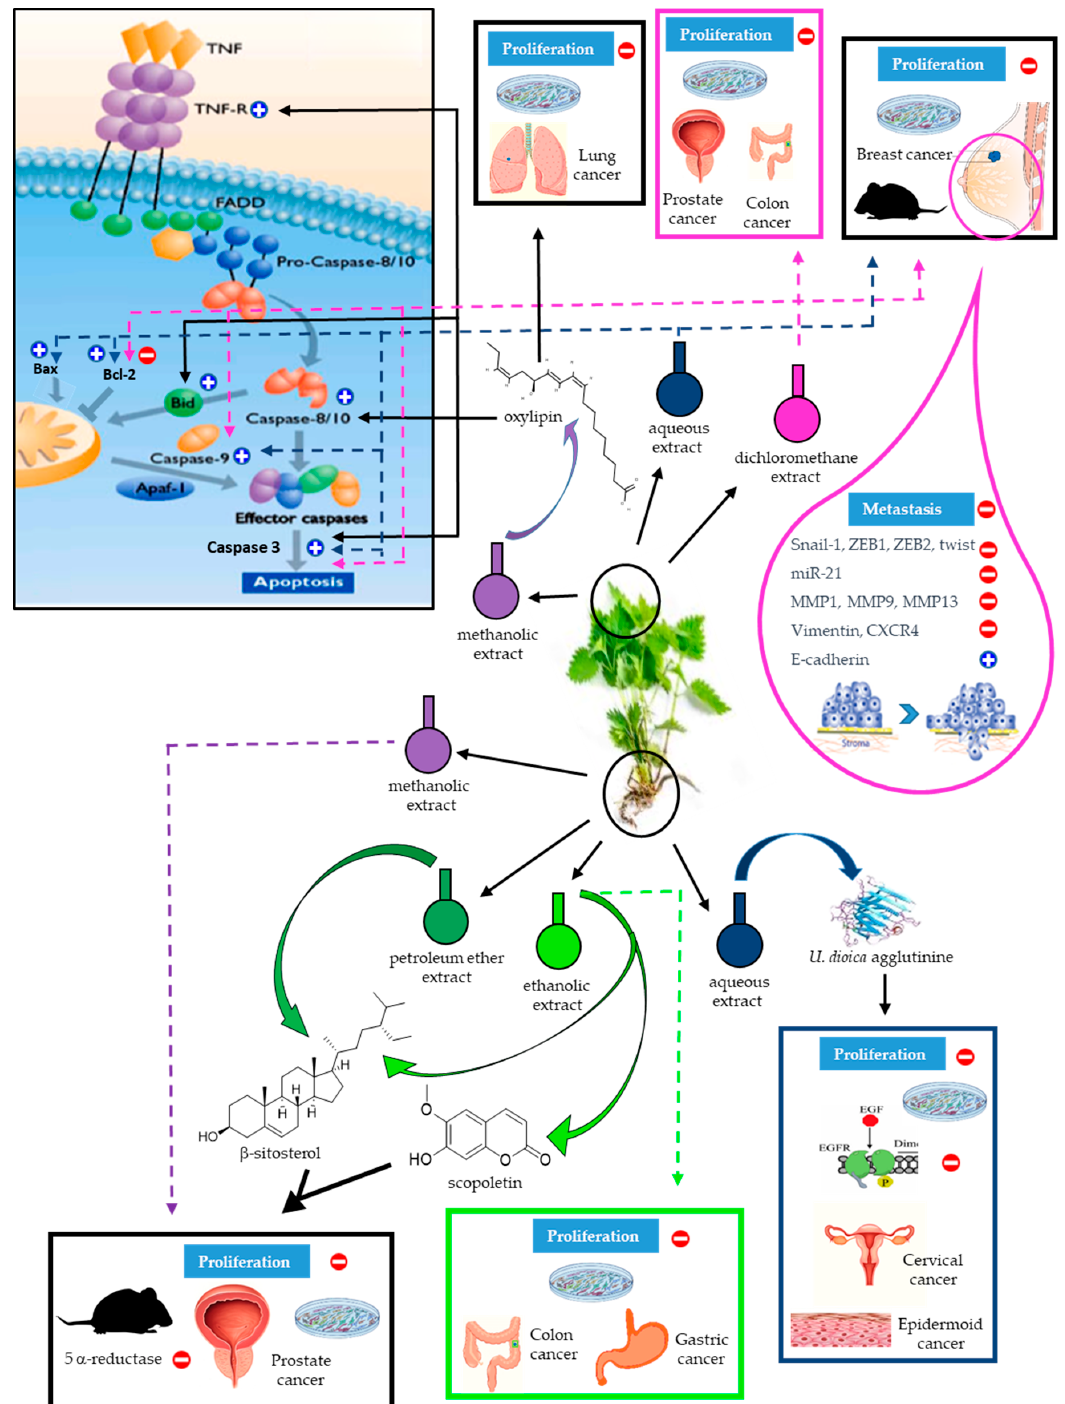
ff ects. Each U. dioica extract and its e ff ects are Figure 4. Schematic drawing of U. dioica anti-cancer effects. Figure 4. Schematic drawing of U. dioica anti-cancer e identified using di ff erent color codes. The dashed arrows denote the results obtained with whole extracts; the solid arrows indicate the specific molecules isolated from the extracts and their e ff ects. A generic picture of apoptosis signalling, indicating where and how molecules or extracts of U. dioica act on the di ff erent cellular targets, is included. By di ff erent images are specified if these results were observed in-vitro or in-vivo, on specific cancer